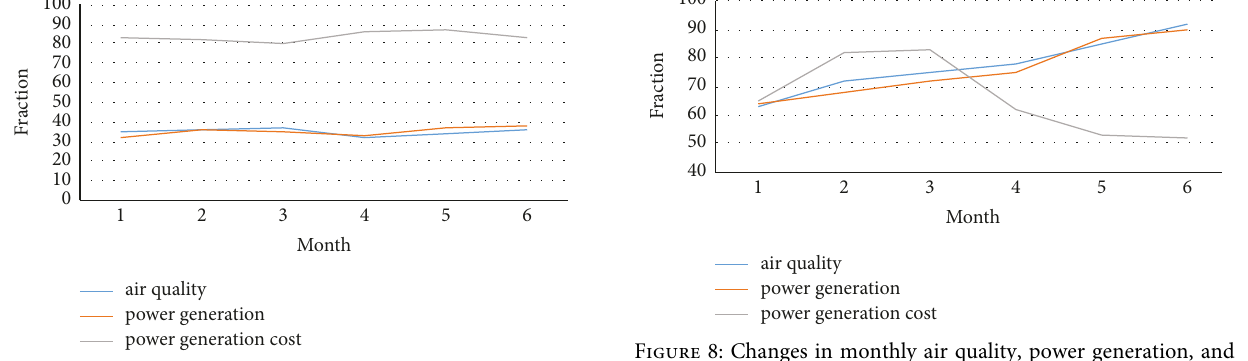
power generation costs in region